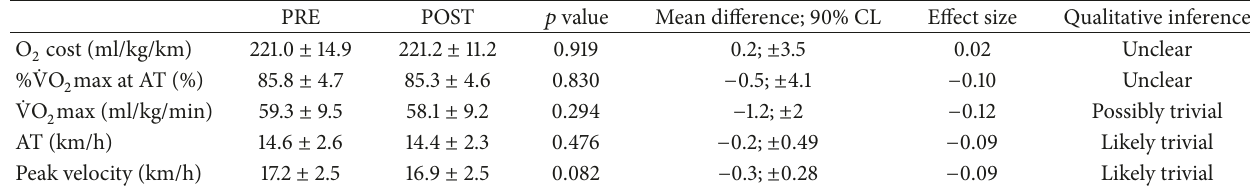
Table 2: Changes in aerobic fitness before and seven days after a marathon